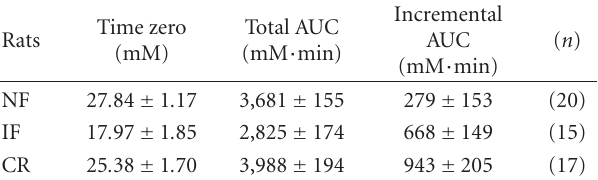
Table 3: IPGTT glycemic data in STZ